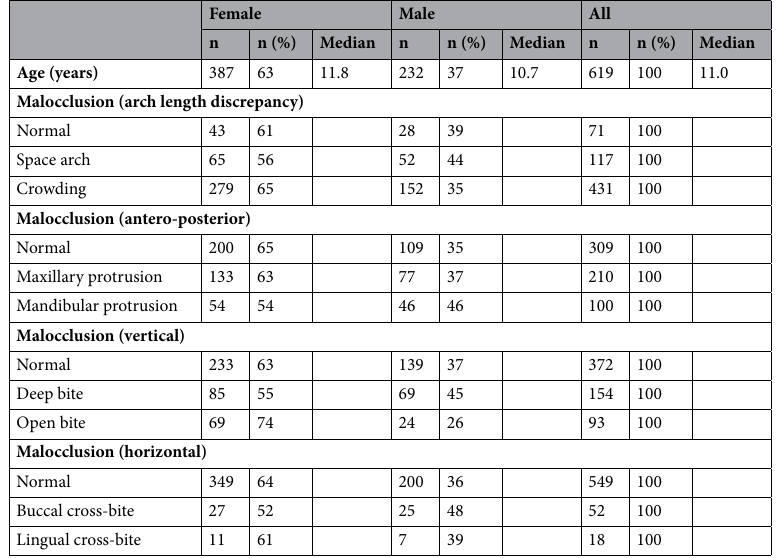
Table 1. Baseline of subjects’ characteristics.